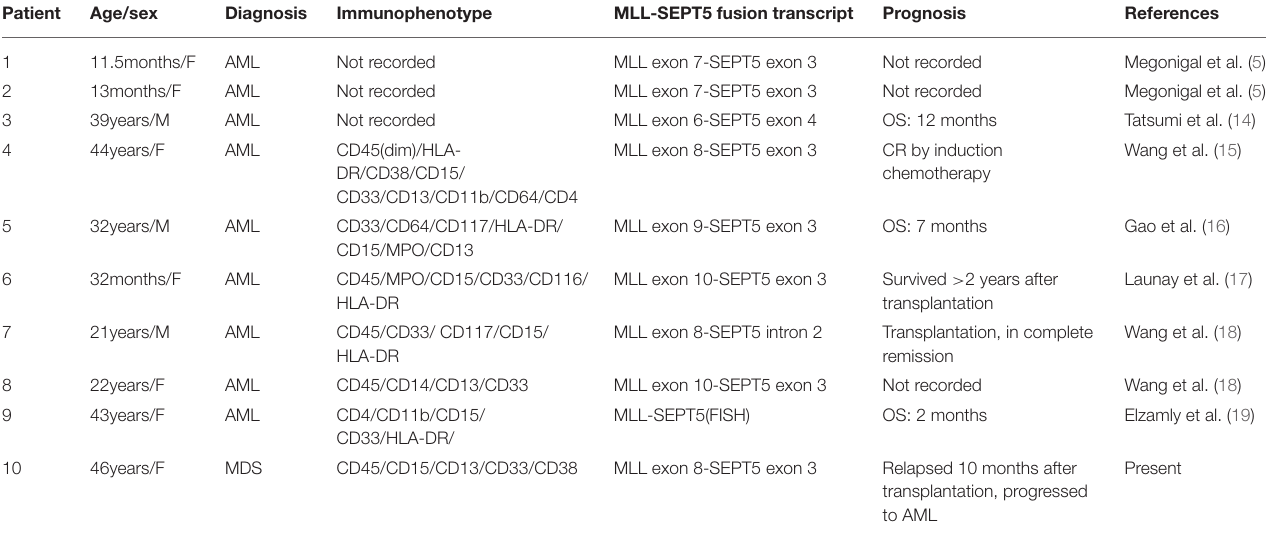
TABLE 1 | Clinical and molecular features of patients with